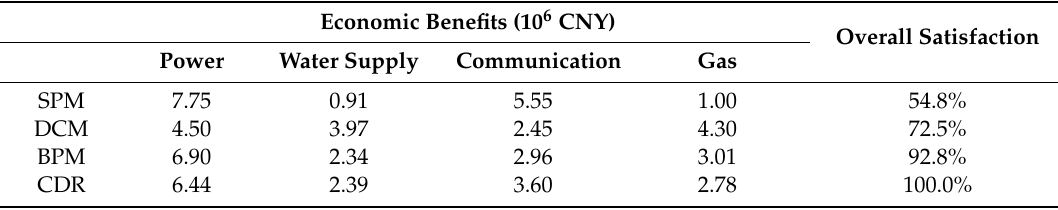
Table 4. Economic benefits and overall satisfaction of pipeline